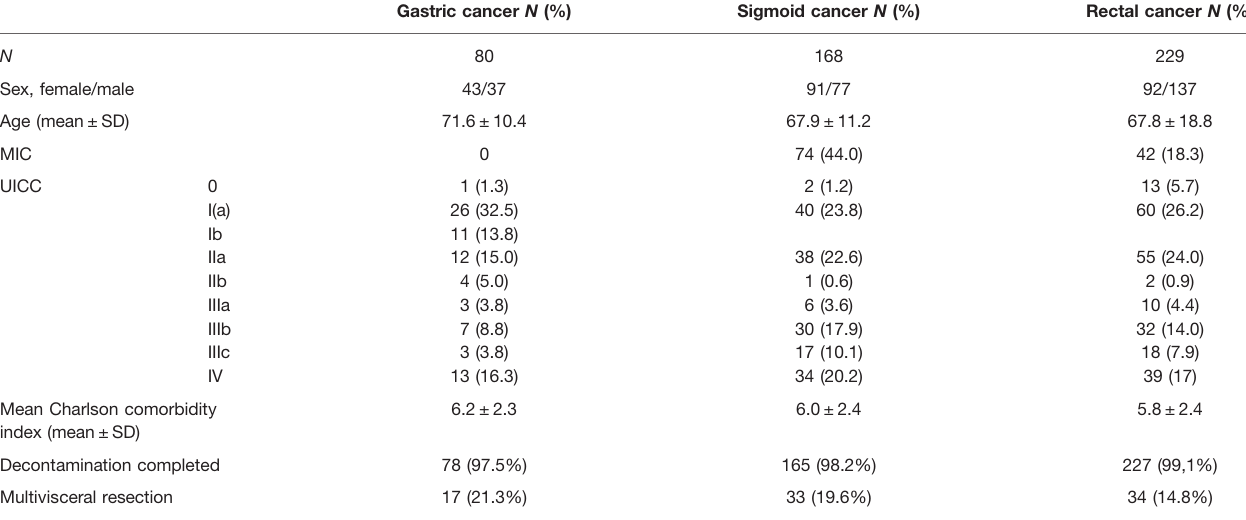
TABLE 1 | Demographic and descriptive information about the patients ’ cohort.